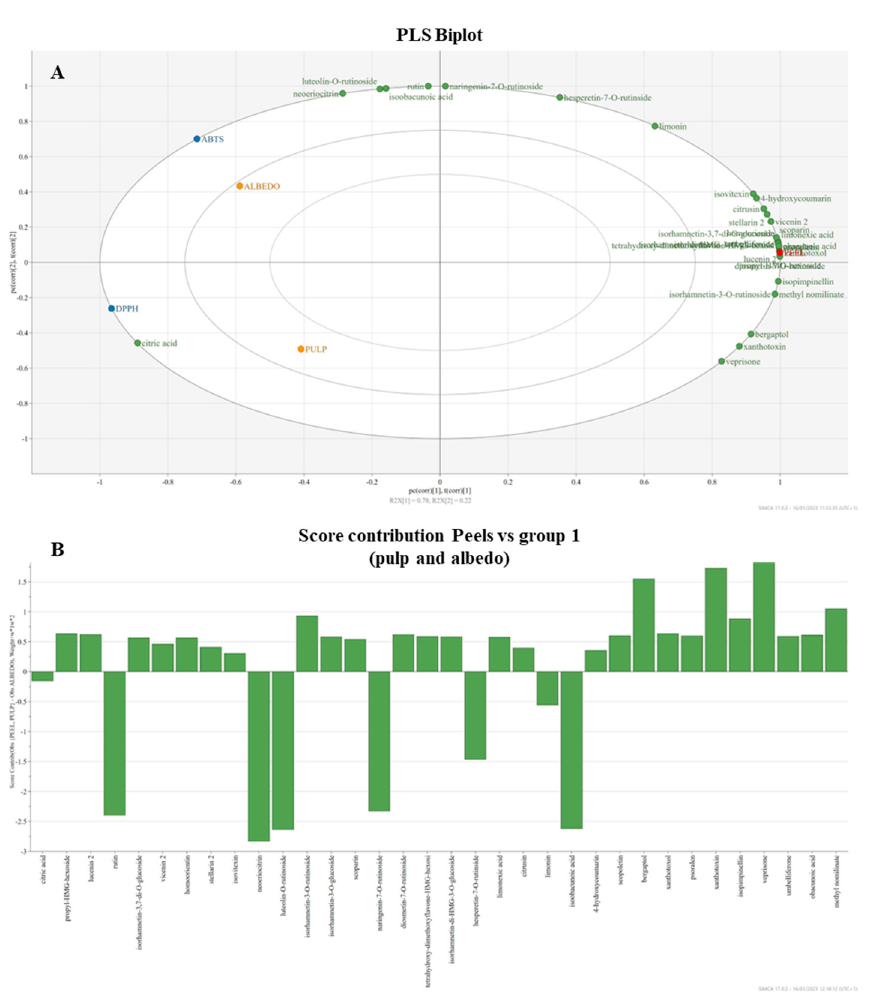
Figure 2. Biplot of PLS analysis performed on peels, pulp, and albedo for the identified non-volatile compounds ( A ). Contribution diagram of the constituents on the distribution of samples ( B ).